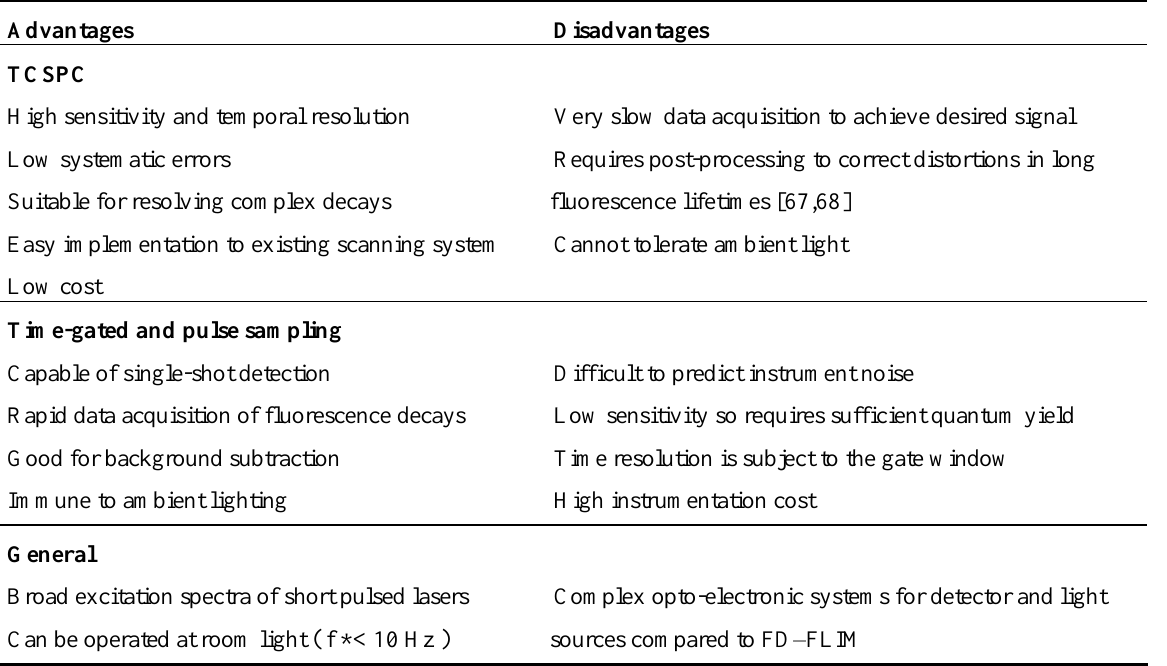
Table 3. Summary of time-domain techniques